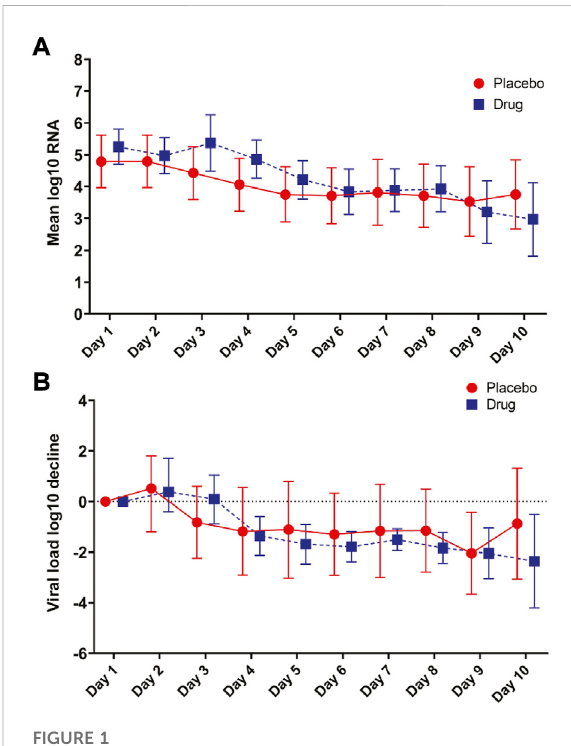
FIGURE 1 Primary Outcome. (A) Mean log SARS-CoV-2 viral RNA in placebocomparedtoatovaquoneoverthe10-daystrialperiod. (B) Viral load decline in placebo and atovaquone groups. No statistically signi fi cant difference was detected between the two groups.